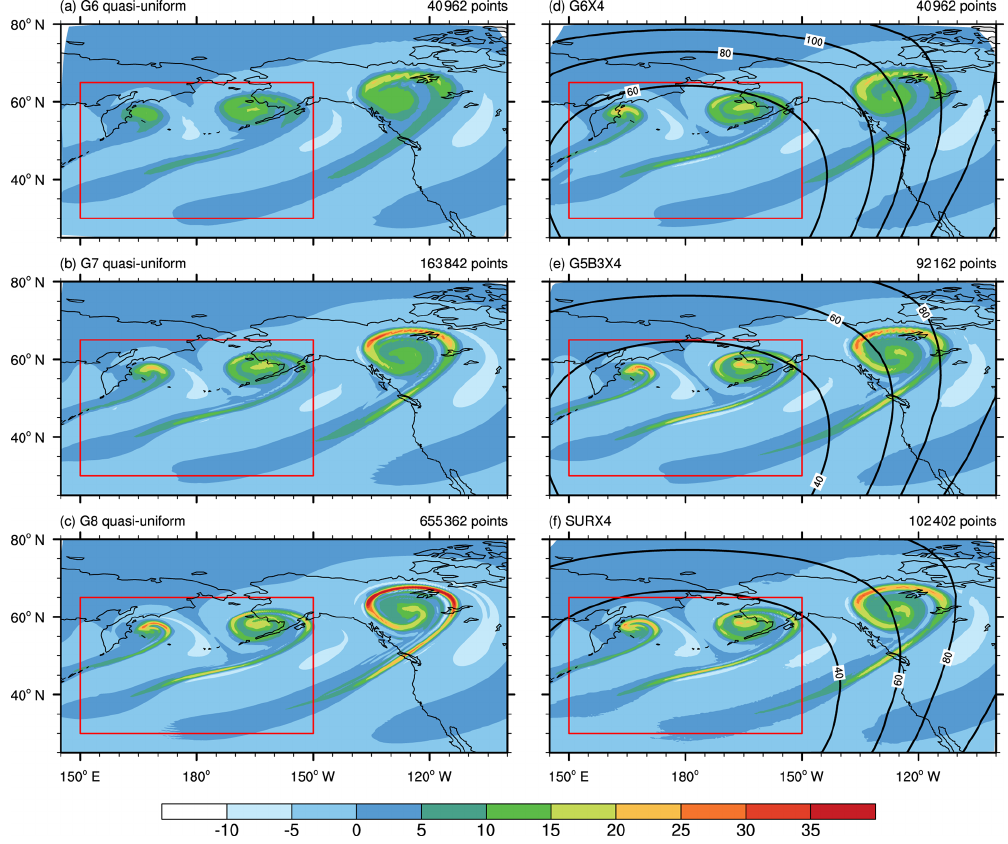
Figure 3. The relative vorticity (10 − 5 s − 1 ) field at the model level nearest to 850hPa (level 24) after 10d. The quasi-uniform (a–c) and variable-resolution (d–f) results are shown. The vorticity is remapped from the raw triangular cell to the Voronoi cell using an area-weighted approach (true for all vorticity values shown in this study). See Fig. S1 also for the remapped QU model solutions on a regular latitude– longitude grid. The red box denotes the region for regional kinetic energy analysis in Fig. 4. The contour lines denote the smoothed mesh cell sizes